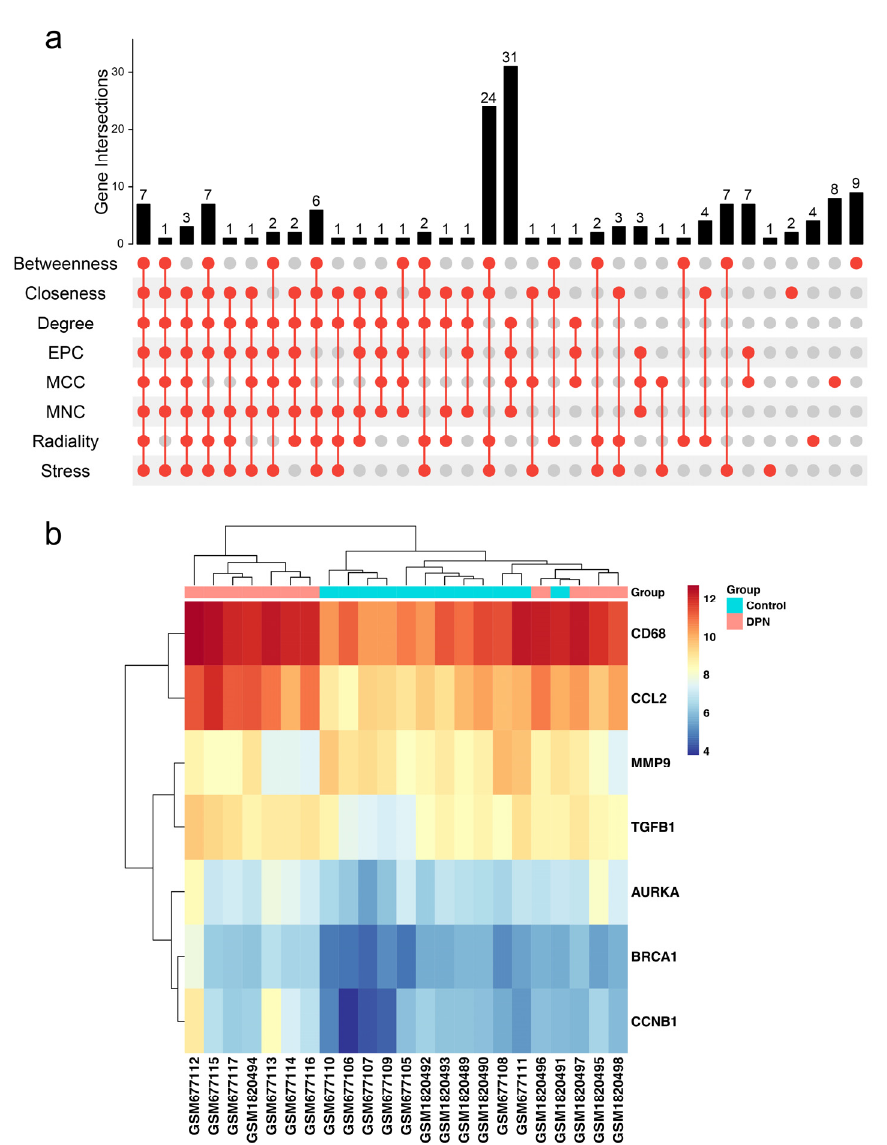
Figure 4. Identification of hub genes in the PPI network. ( a ) Eight algorithms were used to screen hub genes by the R package “UpSet”. ( b ) The expression of hub genes is presented by a heatmap in the merged microarray data.